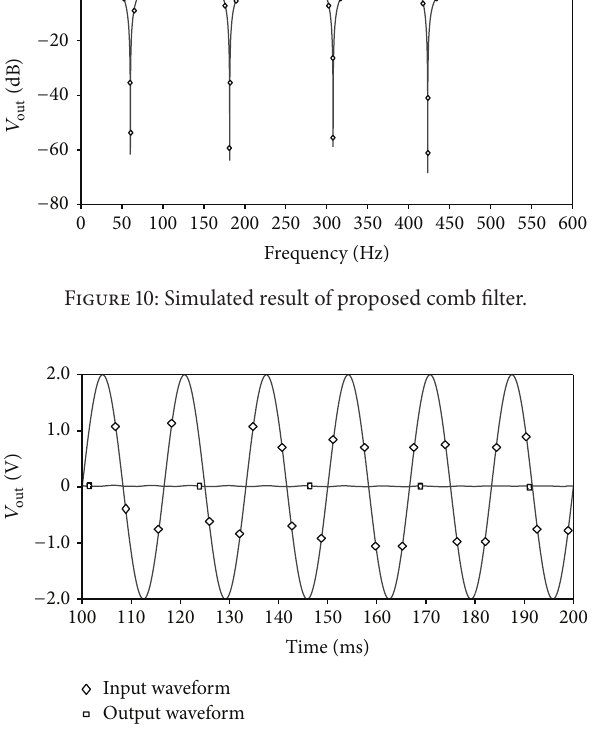
Figure8:Variationoftransconductance 𝐺 withcontrolvoltage 𝑉